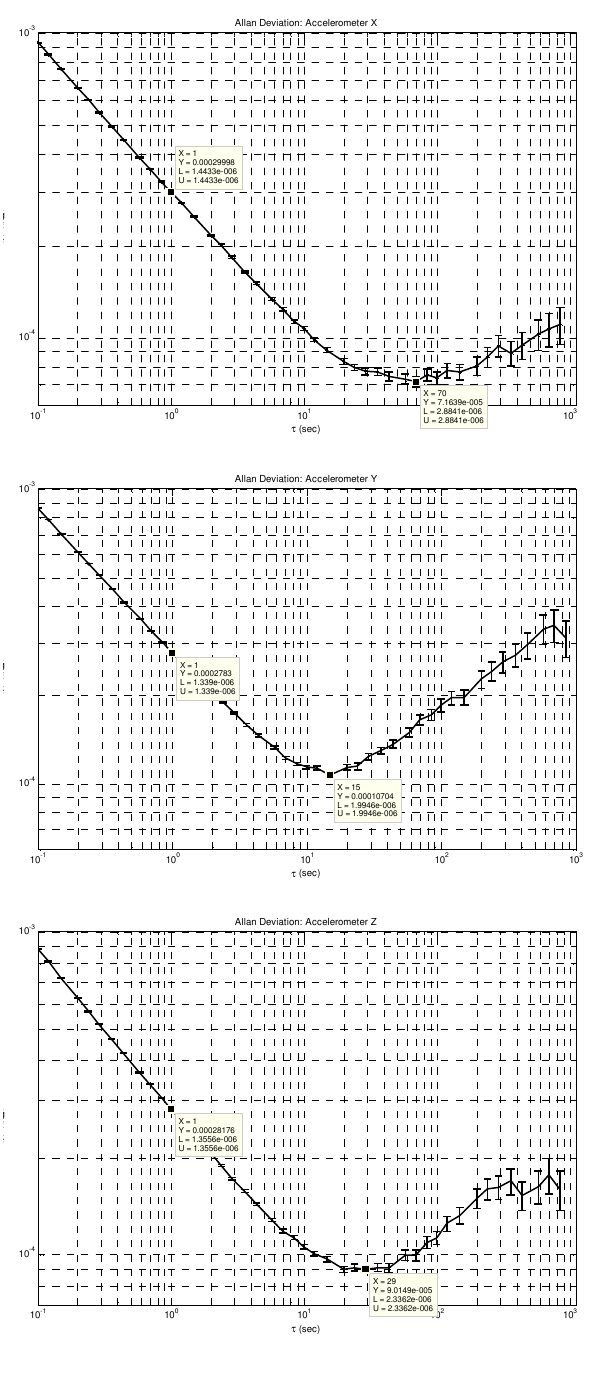
Fig. 4. Error analysis of accelerometers (X – averaged time, Y – Allan deviation, L – lower sigma boundary, U – upper sigma boundary)